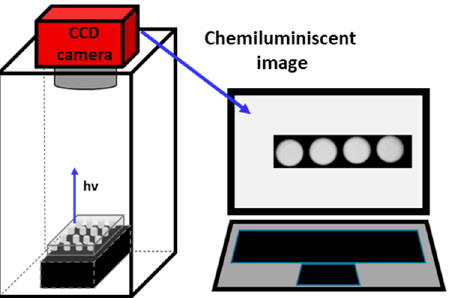
Figure 1. Schematic diagram of the CCD camera dark chamber used for the determination of CHLA. The measurement was performed in a multiplate by mixing luminol (100 μ L) and persulfate (100 μ L). After 5 min, 100 μ L of the blank, working standards, or samples, pre ‐ pared in a carbonate buffer (0.3 M, pH 10.8), were added, and the image was registered. The working concentration interval was up to 500 μ M for CHLA. Trolox was also meas ‐ ured as another example of the antioxidant analyte.